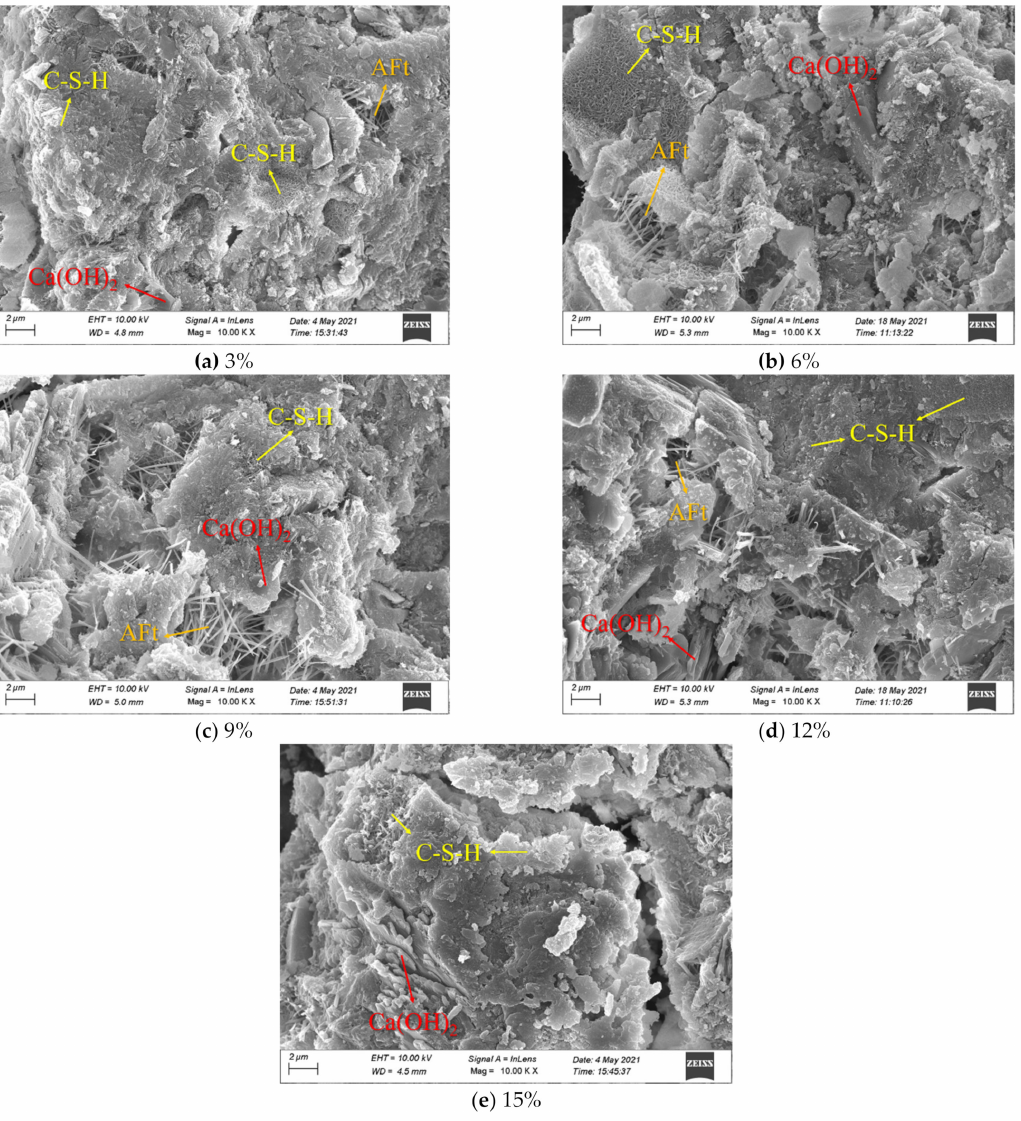
Figure 9. SEM micrographs of samples with different expansion agent contents (quartz sand